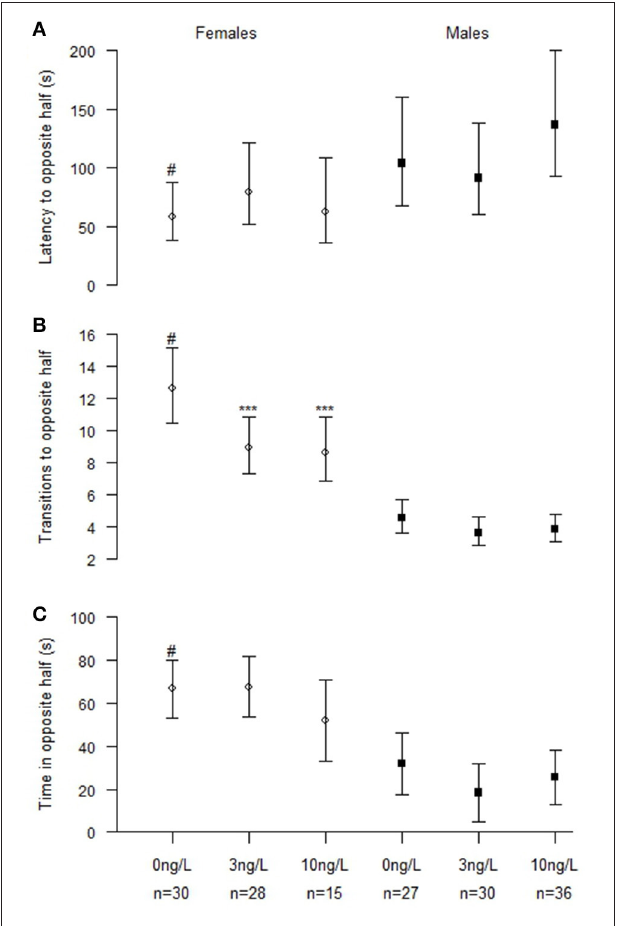
FIGURE 3 | Scototaxis behavior in male and female zebrafish developmentally exposed to 0, 3, or 10ng/L EE 2 and remediated in clean water for 120 days. (A) Latency time before entering the white half, (B) Number of transitions to the white half, and (C) Total time spent in the white half. Data represent mean ± 95% CI, # p < 0.05, * p < 0.05, ** p < 0.01, *** p < 0.001. *Significantly different from control fishes of the same sex, # control females significantly different from control